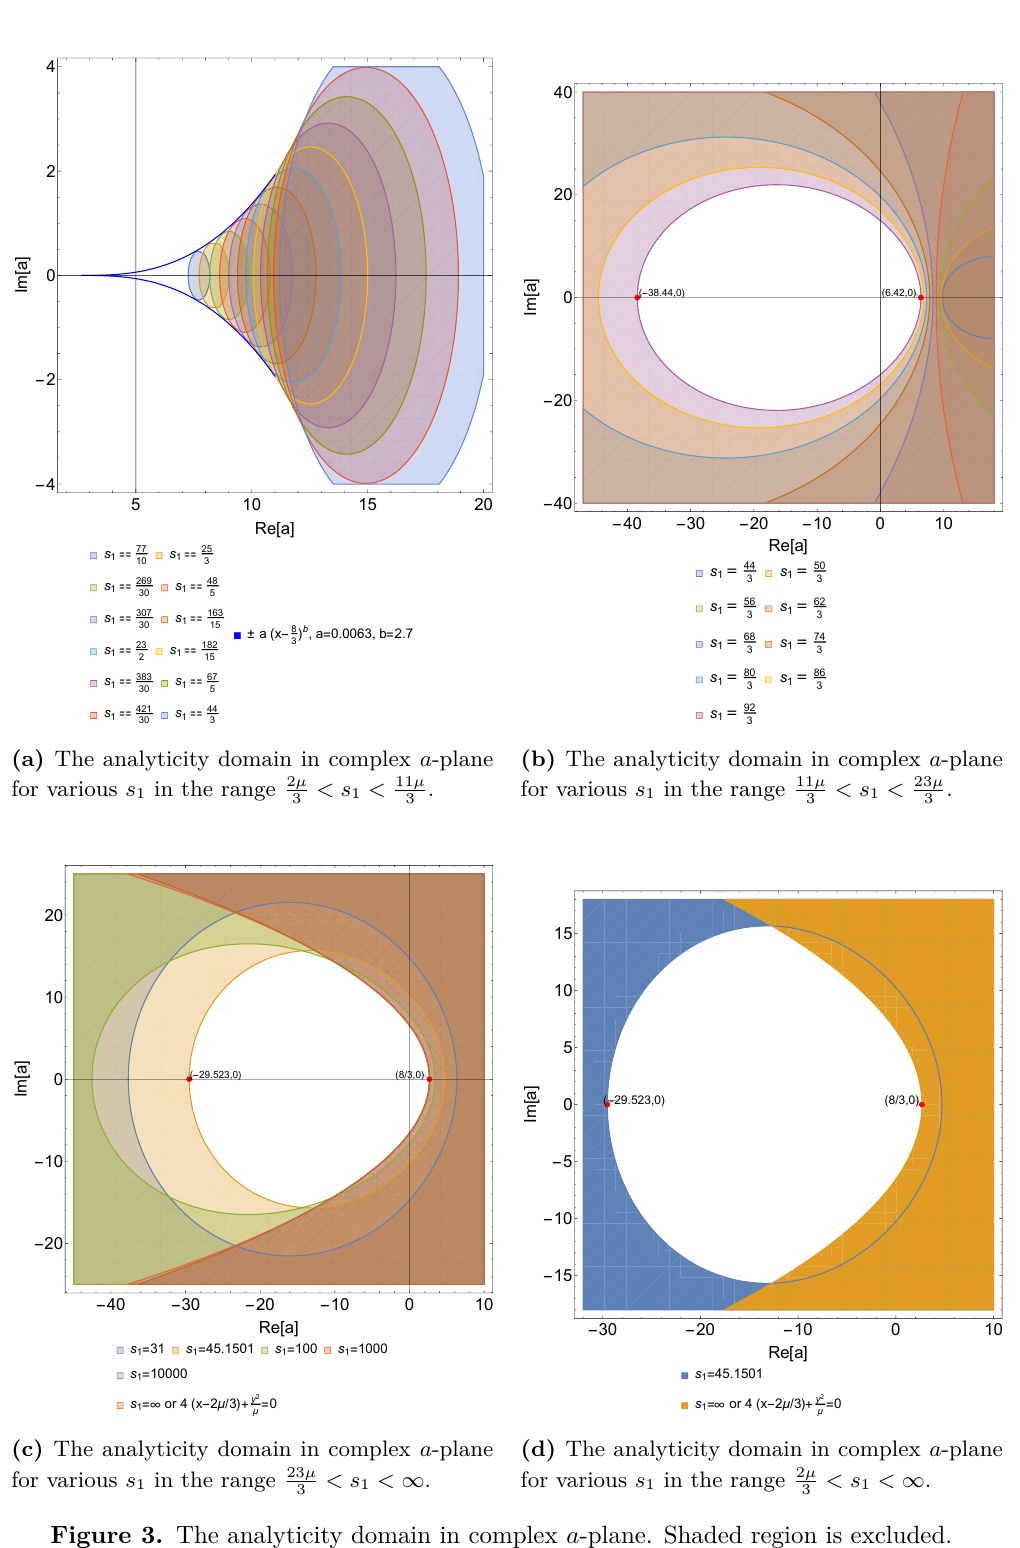
Figure 3. The analyticity domain in complex a -plane. Shaded region is